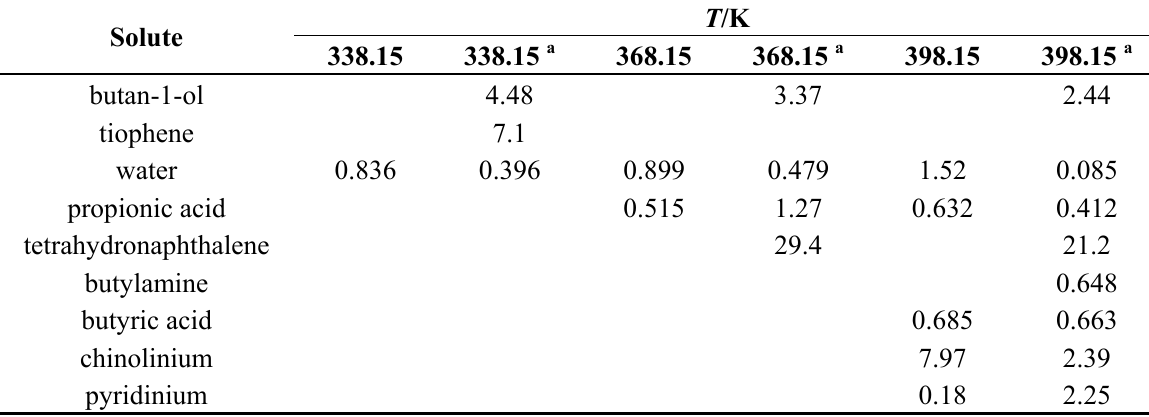
γ for the solutes in the 13 ] (19.82 w %) + β -CD (9.04 w %)} 2